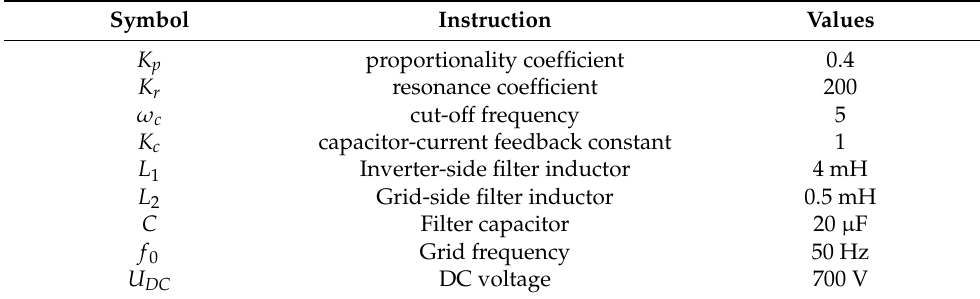
Table 1. Control and electrical parameters of the